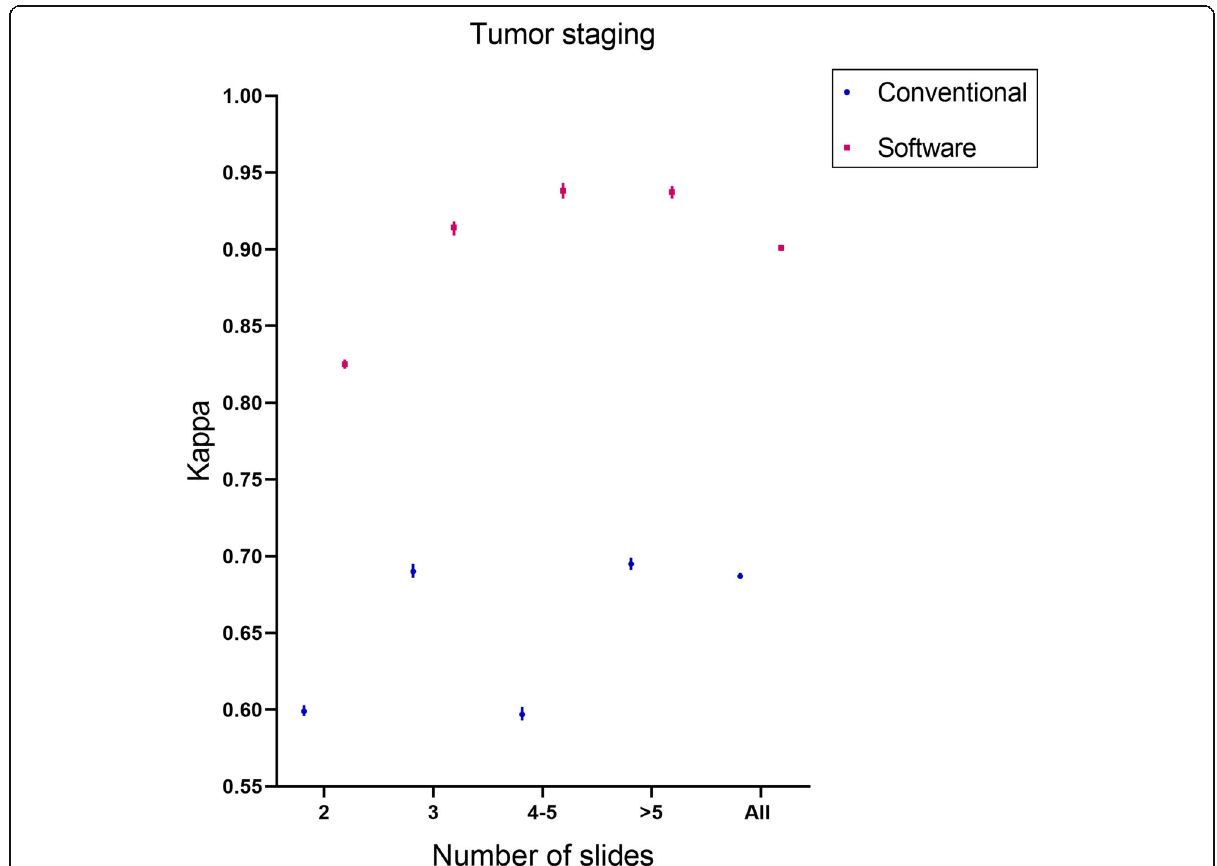
Fig. 6 Comparison of tumor staging consistency between the software-assisted method and conventional method by five